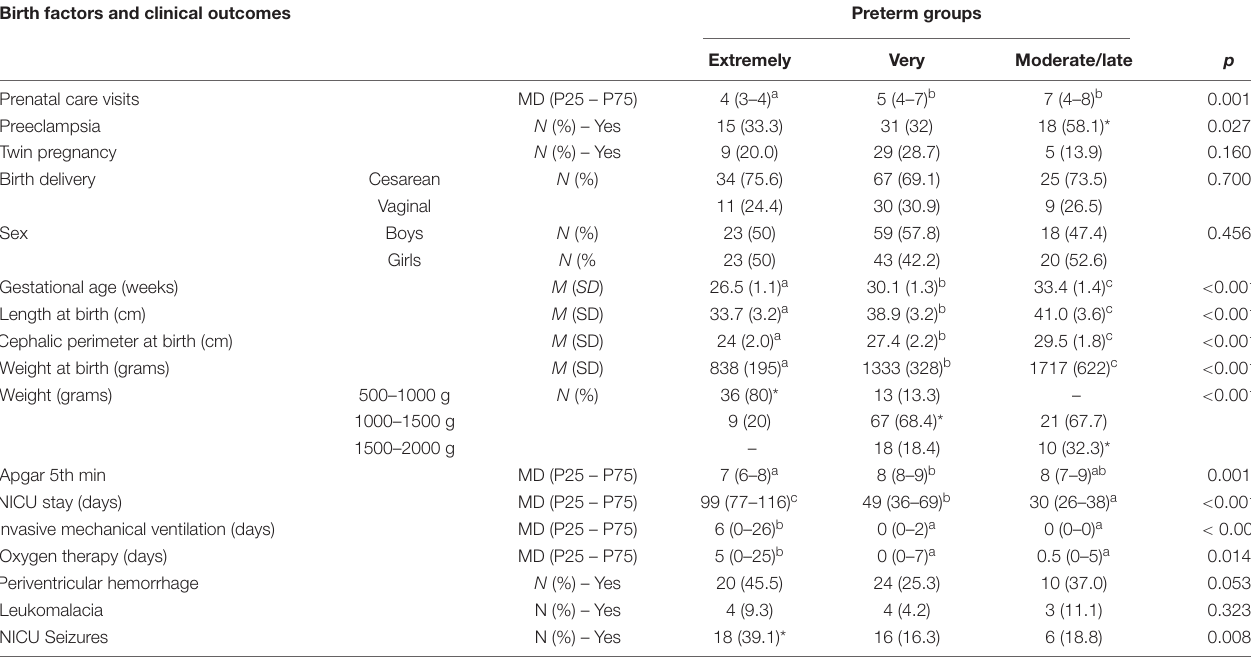
TABLE 2 | Birth risks and clinical outcomes and group comparisons.